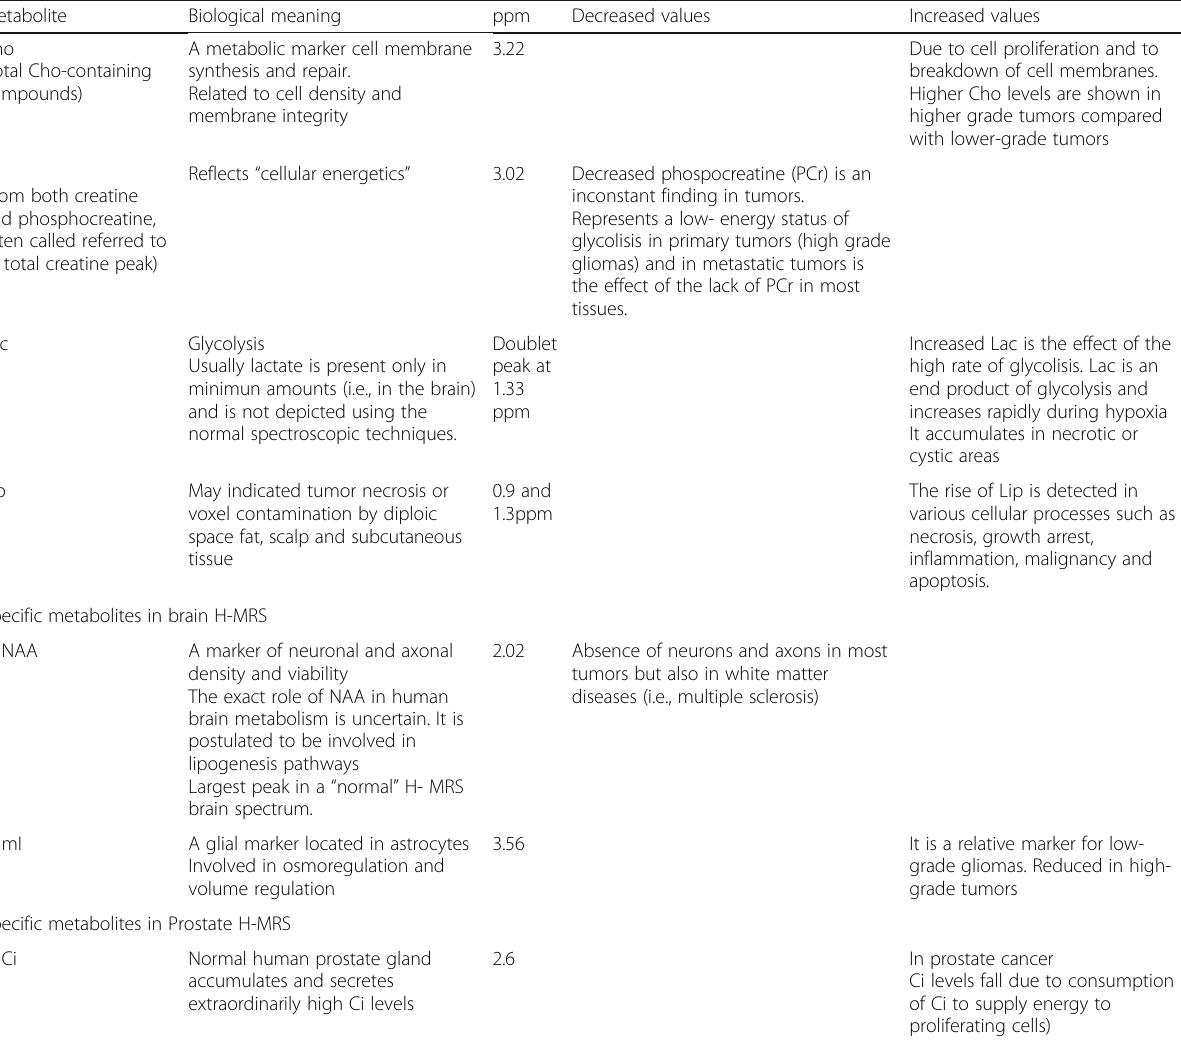
Table 3 Main metabolites studied in 1 H-MRS and their biological significances Metabolite Biological meaning ppm Decreased values Increased values Cho (total Cho-containing